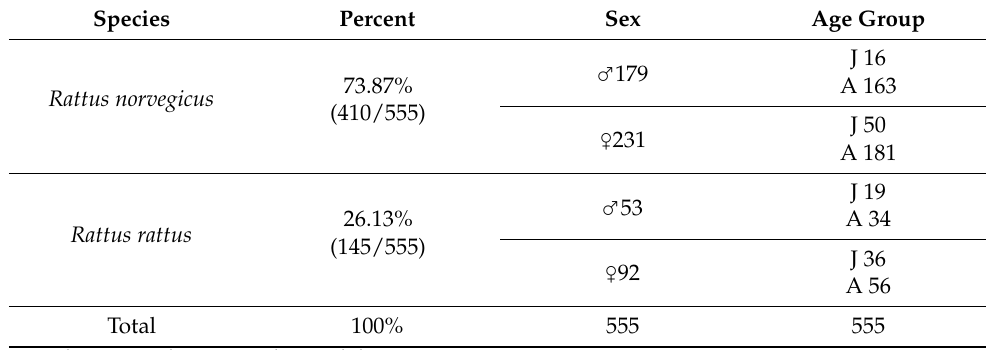
Table 1. The layout of the species, sex, and age group of rats captured on the pig farms in Colombia. Species Percent Sex Age Group